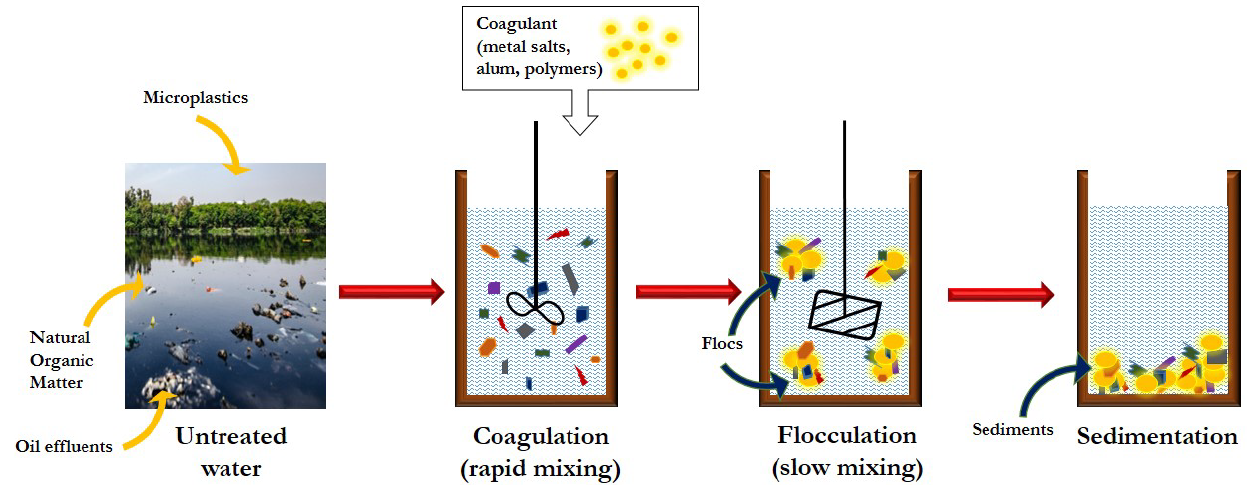
Figure 9. Microplastic removal by coagulation, flocculation and sedimentation processes.